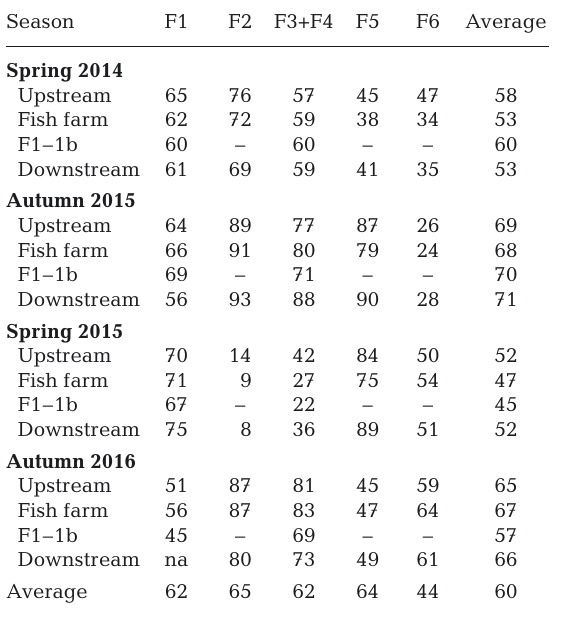
Table 2. Percentage of cyanobacteria (both filamentous/ colony forming and coccoid/pico-sized) in relation to the total phytoplankton chl a biomass at the different fish farms (F1 to F6; two farm areas, 1a and 1b, within F1 given as ‘Fish farm’ and ‘F1–1b’, respectively). –: not applicable; na: not